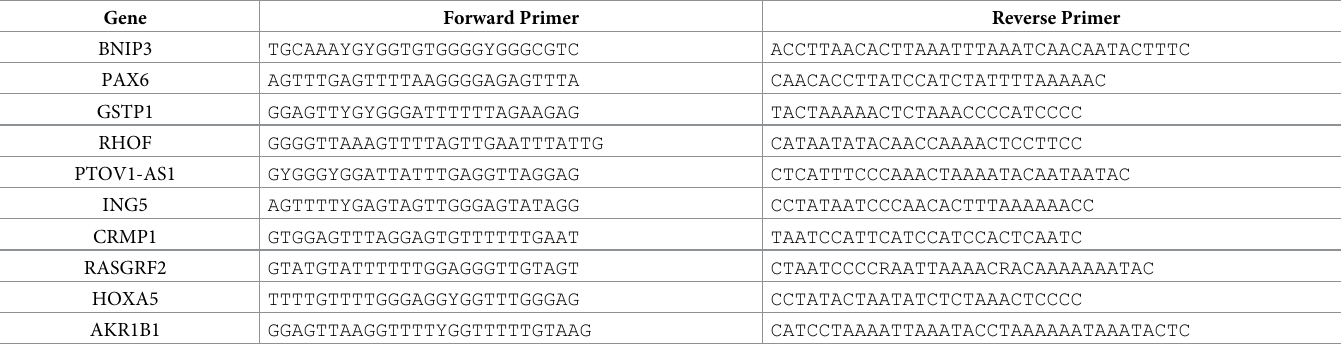
Table 2. The primers for targeted bisulfite